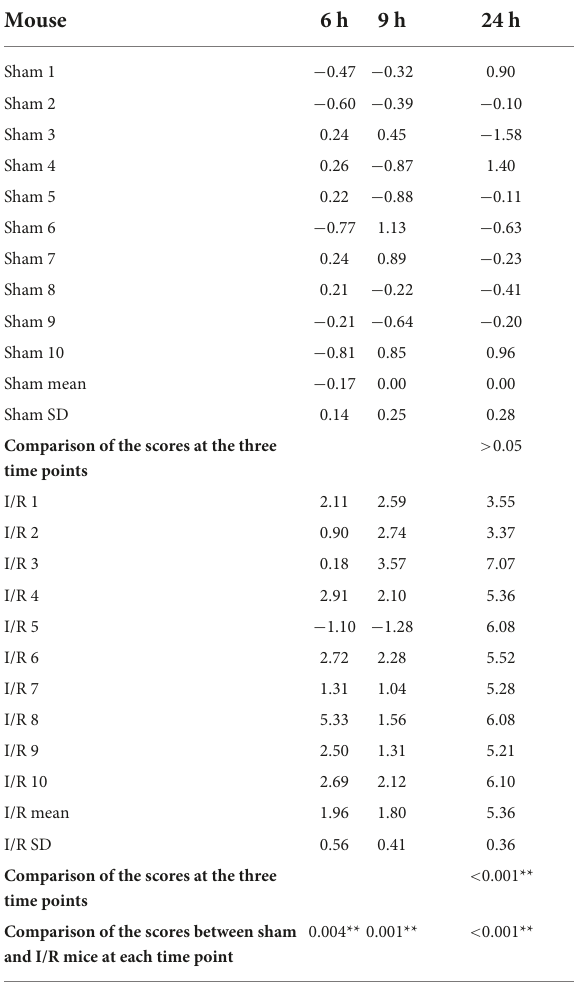
TABLE 2 Summary of composite Z scores in sham and I/R mice.